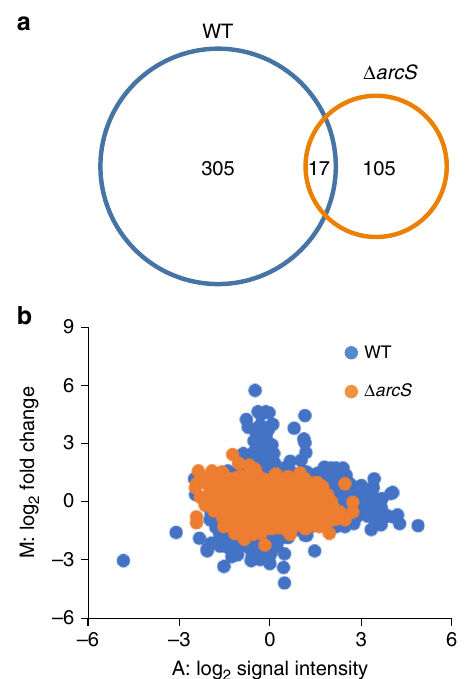
Fig. 6 Electrode potential-dependent transcriptional changes in WT and Δ arcS . a Venn diagram showing the number of electrode potential- responsive genes found in WT and Δ arcS . b Mean average (MA) plots of microarray data for WT and Δ arcS . M and A values indicate log 2 - transformed fold changes and normalized signal intensities for each microarray probe,